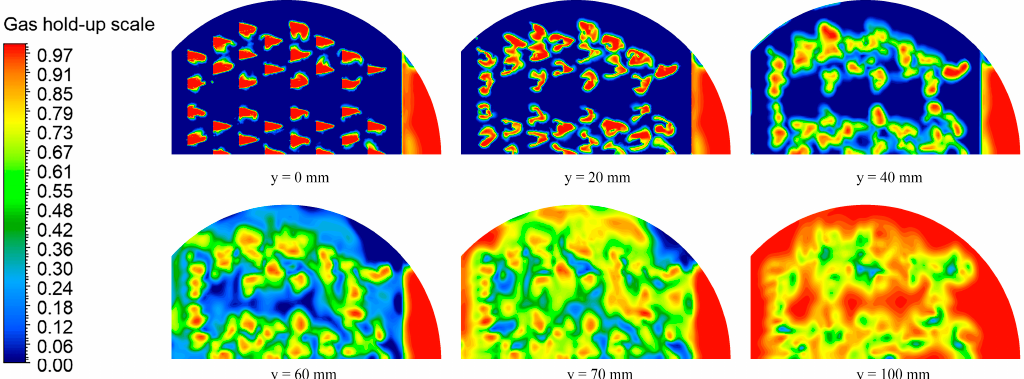
Figure 10. Gas hold–up snapshots of the top view at different heights of the parabolic–shaped guided valve tray.